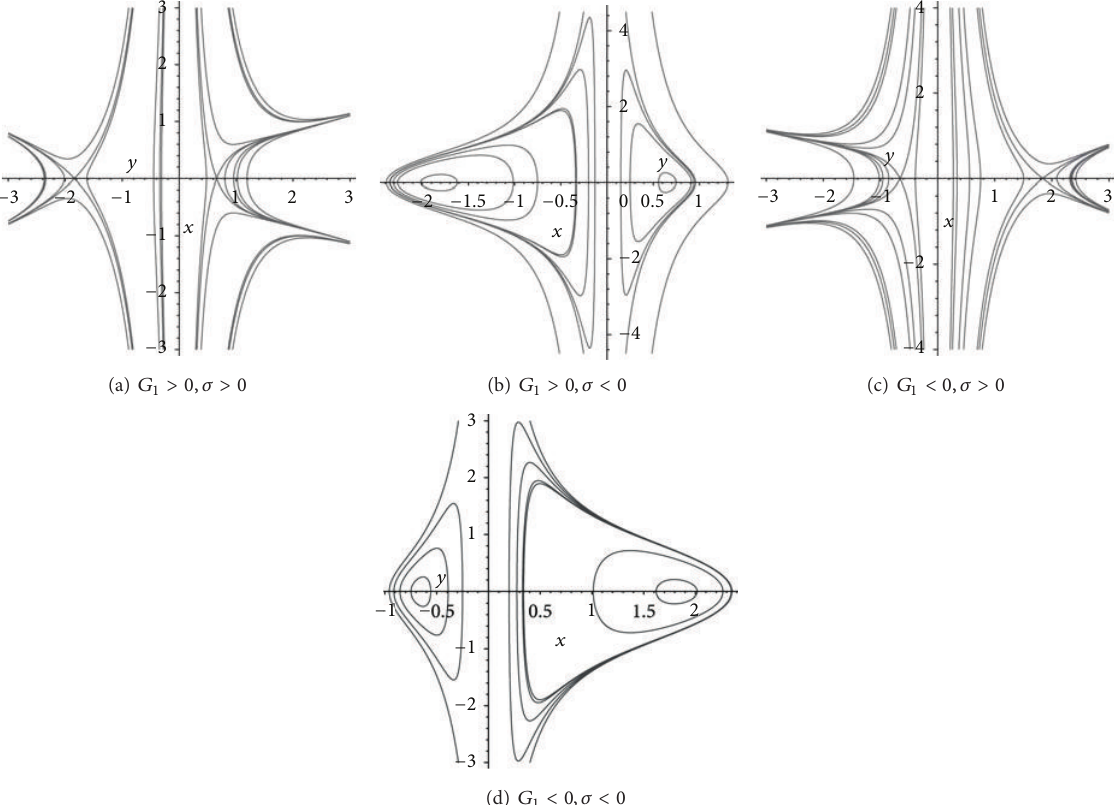
Figure 10: The phase portraits of system (6) for 𝑛 = 2𝑚 + 1 , and 𝛽 < 0